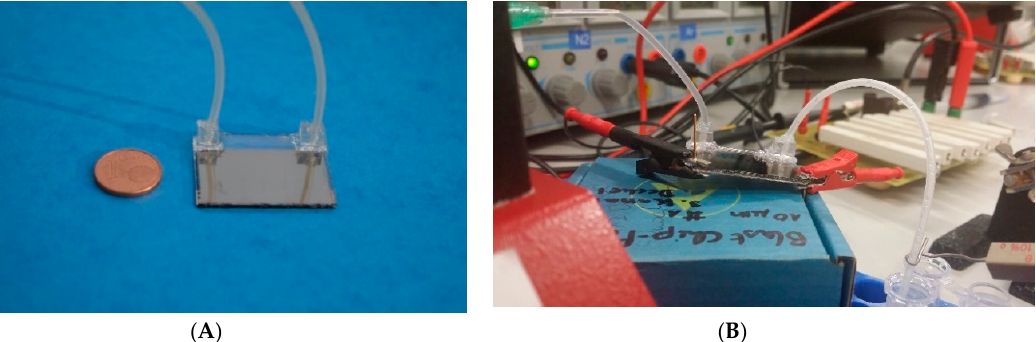
Figure 1. ( A ) Manufactured chip for irreversible electroporation. Two glass slides with platinum metallization are bonded together. A meander-type microfluidic channel is embedded between the two slides. Inlet and outlet tubes are connected via custom-made poly(dimethylsiloxane) (PDMS) connectors. ( B ) Experimental setup. The inlet tube is on the left side of the chip; the outlet tube on the right feeds directly into an Eppendorf tube (here not ice-cooled). In the background, the board (right) and the electronic equipment is shown. For both pictures: Footprint of the chip: 32 × 26 mm.